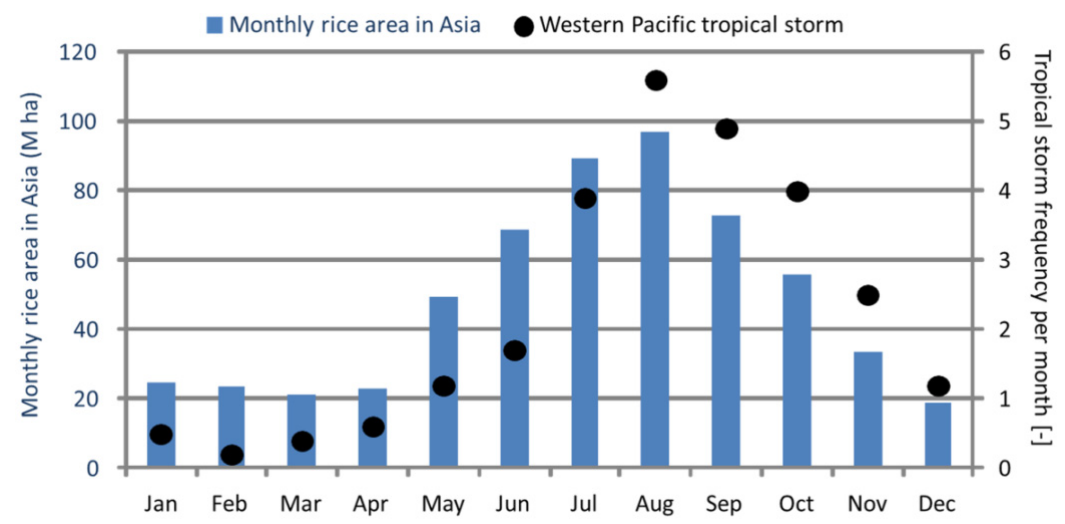
Figure 1. Monthly rice area (M ha) in Asia vs . average number of tropical storms per month in the western Pacific between 1959 and